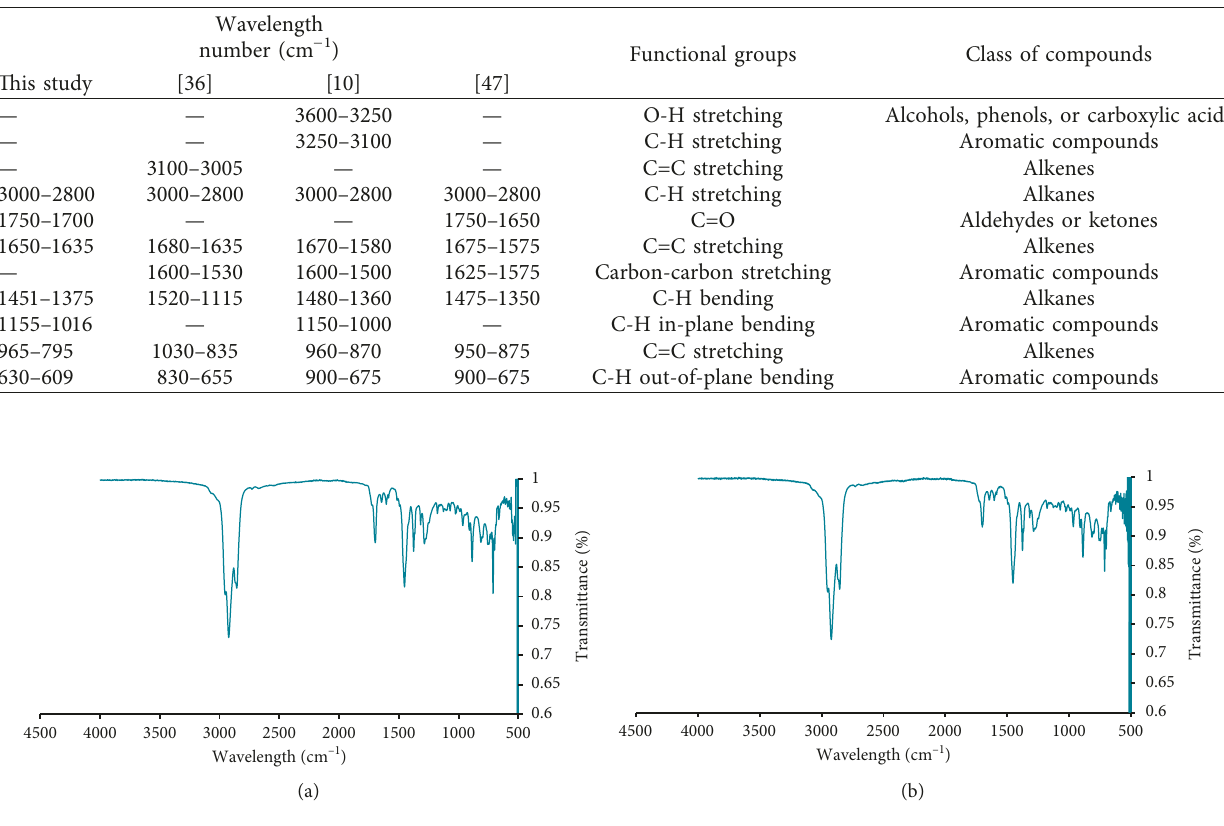
Figure 4: (a) FTIR transmittance spectrum for used tires pyrolytic oil. (b) FTIR transmittance spectrum of catalyzed pyrolytic oil from used tires. Table 6: 1 H and 13 C NMR results for various catalysts-to-used tire pyrolytic oil obtained at 600 ° C. Types of hydrogen